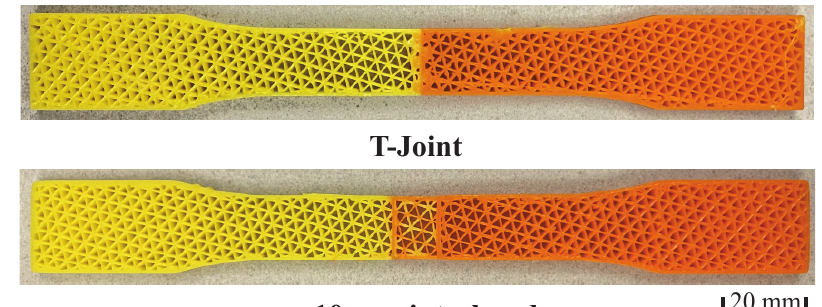
Figure 9. The dog-bone samples for tensile